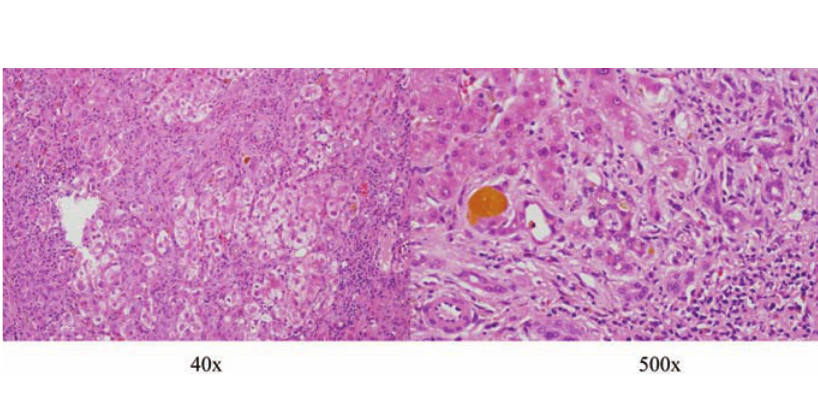
Figure 2. Liver biopsy in 2006 - severe cholestasis with fibrosis, ductular proliferation and cirrhosis (Haematoxilyn and Eosin